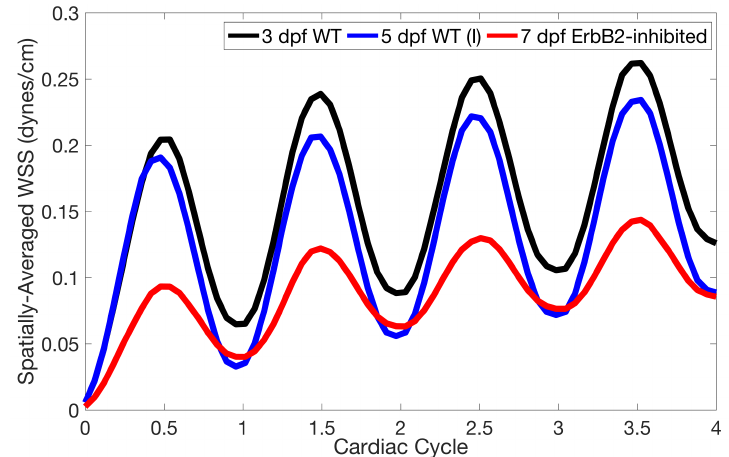
Figure 13. A plot showing the spatially-averaged magnitude of wall shear-stress (WSS) over the ventricle during the first 4 pulsation cardiac cycles for the 3 dpf WT, 5 dpf WT, and 7 dpf ErbB2-inhibited zebrafish (ZF) for Re = 1. The highest spatially-averaged WSS was in the 3 dpf WT ZF with the least in the 7 dpf ErbB2-inhibited ZF geometry.